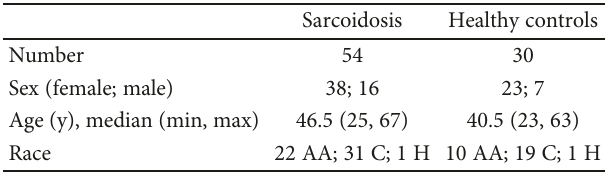
Table 1: Demographics of sarcoidosis and control PBMC populations.